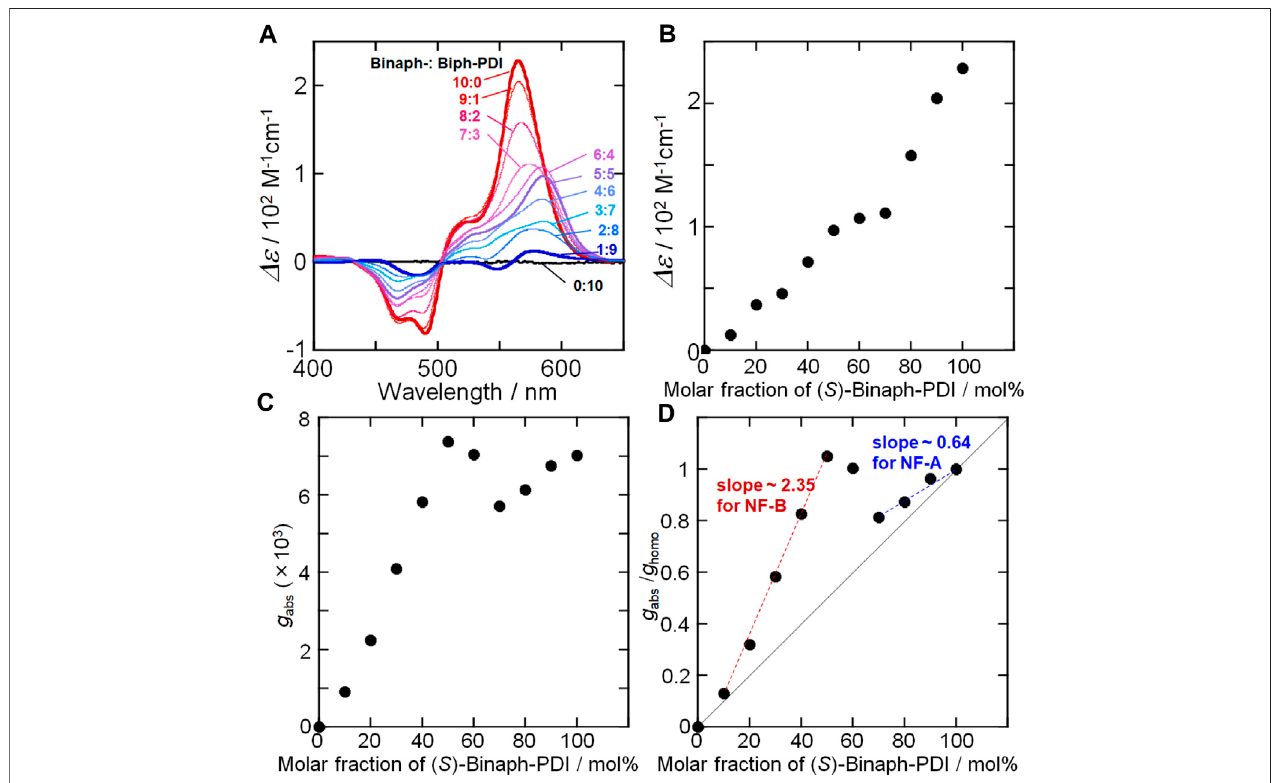
FIGURE 6 | (A) CD spectral change of Biph-PDI-( S )-Binaph-PDI coassemblies in a mixture (1:19) of chloroform/MCH (B) – (D) Plots of molar CD, g g homo values as a function of molar fraction of ( S